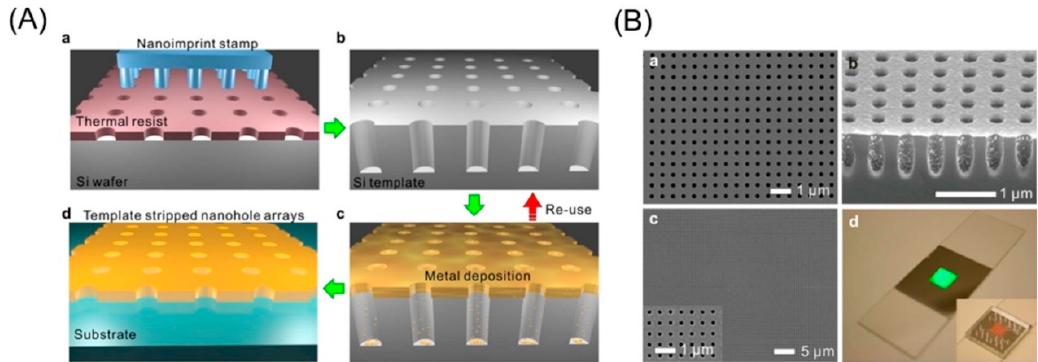
Figure 4. ( A ) Schematic for fabricating the large-area nanohole arrays. ( a ) A thermal resist layer spun on a Si wafer is imprinted with a nanoimprint stamp with circular post patterns. ( b ) The Si wafer is subsequently etched to be a nanohole template with deep circular trenches. ( c ) A metal film is directionally deposited on the Si template. ( d ) The metal surface is coated with a thin layer of epoxy and covered with a glass slide. The Ag film is then peeled off of the template to reveal the smooth nanohole array made in the metal film. The Si template can be reused to make multiple identical samples. ( B ) ( a ) A SEM image of the Si template with deep circular trenches. ( b ) A cross-sectional SEM image of the Si template after depositing a 100 nm thick Ag film. ( c ) A SEM image of the template-stripped Ag periodic nanohole array. The inset shows a zoomed-in image of the template-stripped Ag nanoholes. The diameter of the nanoholes and periodicity of the array are 180 and 500 nm, respectively. ( d ) A photograph of the fabricated nanohole array chip. A 26.5 mm × 26.5 mm area of 100 nm-thick Ag film with nanohole patterns in an 8 mm × 8 mm area in the center is transferred to a standard microscope slide. The inset in panel d shows a photograph of a multi-channel PDMS chip attached on the silica-coated nanohole array chip. Reproduced with permission from Reference [44], Copyright 2011, American Chemical Society.